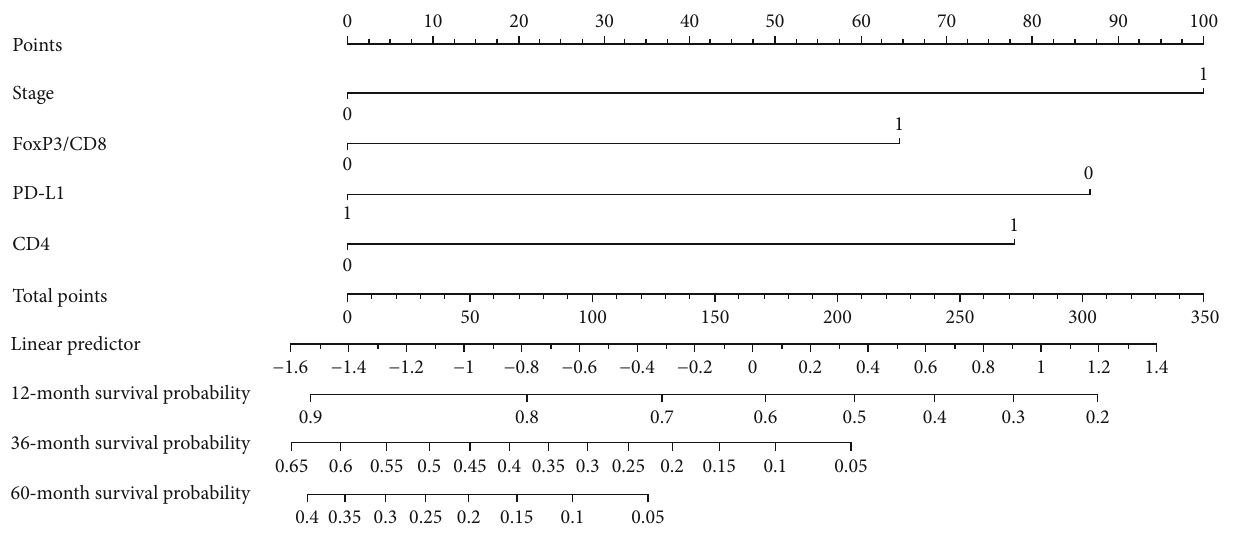
Figure 5: Development of the nomogram for predicting OS in patients with PESCC. To estimate the OS of an individual patient, the value of each factor is acquired on each variable axis, and a straight line is drawn upward to determine the points. The sum of these 4 numbers is located on the total points axis, and then, a line is drawn downward to the survival axes to determine the likelihood of